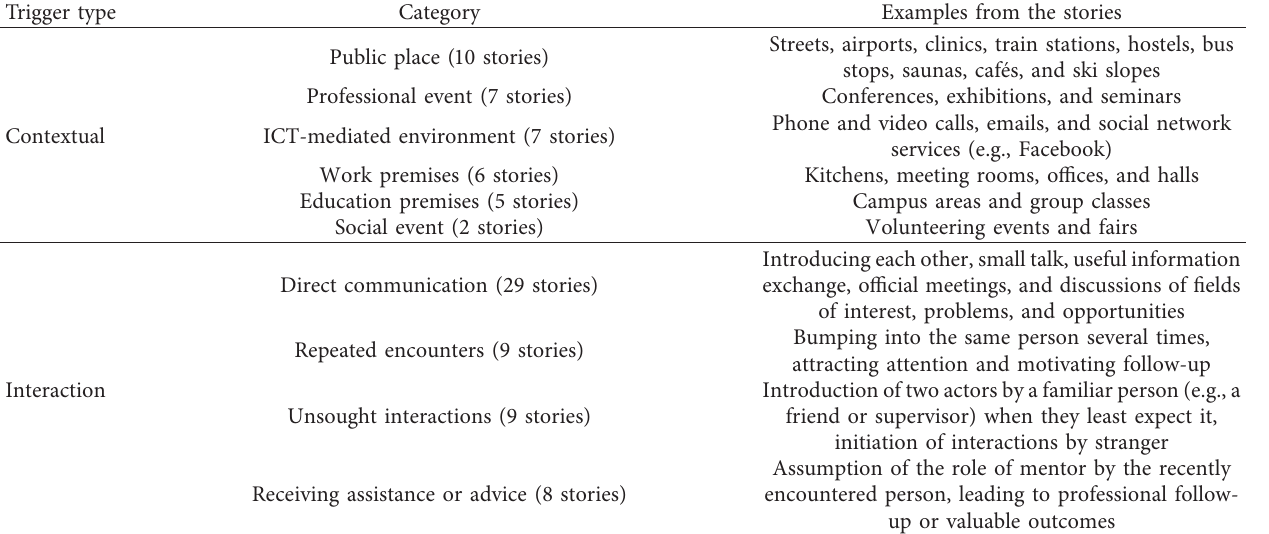
Figure 6: An excerpt from a respondent’s example of an ICT-mediated environment that increased the probability of social serendipity. Table 3: Categories of contextual and interaction triggers identified in the respondents’ stories. Trigger